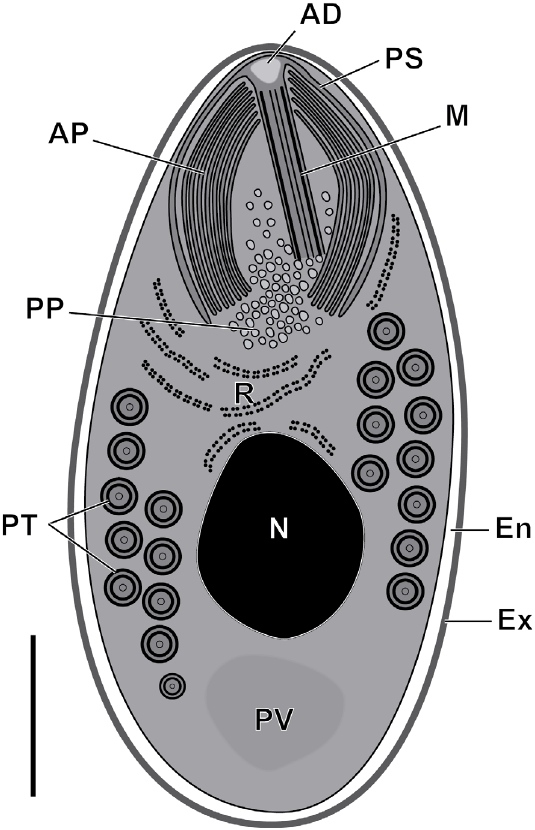
Figure 10. Schematic drawing of the mature spore of Toguebayea baccigeri n. gen., n. sp. AD, anchoring disc; AP, anterior polaro- plast; En, endospore; Ex, exospore; M, manubrium; N, nucleus; PP, posterior polaroplast; PS, polar sac; PT, polar tube; PV, posterior vacuole; R, ribosomes and polyribosomes. Scale bar = 0.5 l